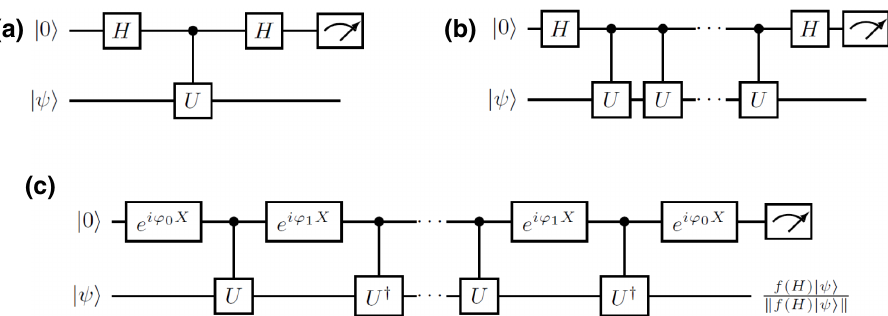
FIG. 1. After a proper rescaling, the n -qubit circuit U implements e − iH and the Hadamard test circuit [(a), short time evolution] estimates Re (cid:2) ψ | e − iH | ψ (cid:3) . Repeating the controlled evolution d times, the circuit shown in (b) estimates the average value of a long time evolution Re (cid:2) ψ | e − idH | ψ (cid:3) . For a very general class of functions f , the QETU circuit shown in (c) can approximately prepare a normalized quantum state f ( H ) | ψ (cid:3) / (cid:6) f ( H ) | ψ (cid:3)(cid:6) with approximate success probability p = (cid:6) f ( H ) | ψ (cid:3)(cid:6) 2 , by interleaving the forward ( U ) and backward ( U † ) time evolution with some properly chosen X rotations in the ancilla